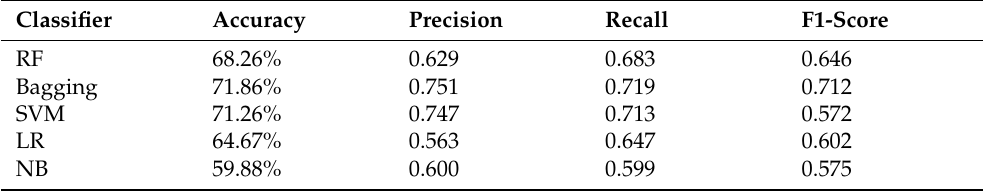
Table 22. Experiments with ML models and Bing Lui + MPQA lexicons on the TextBlob sentiments.